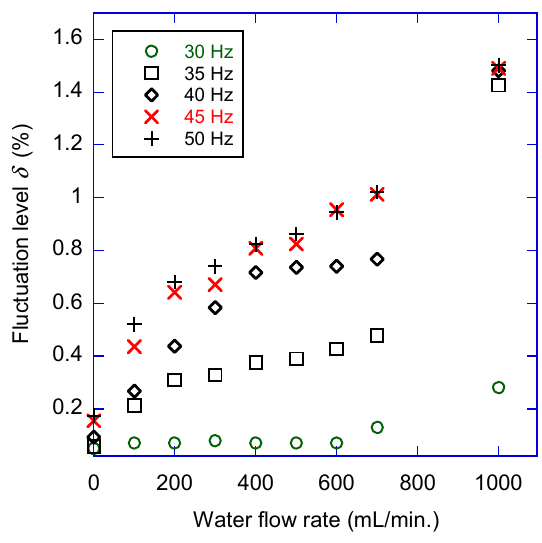
Figure 8. Fluctuation level of resistance vs. water flow rate at different frequencies.